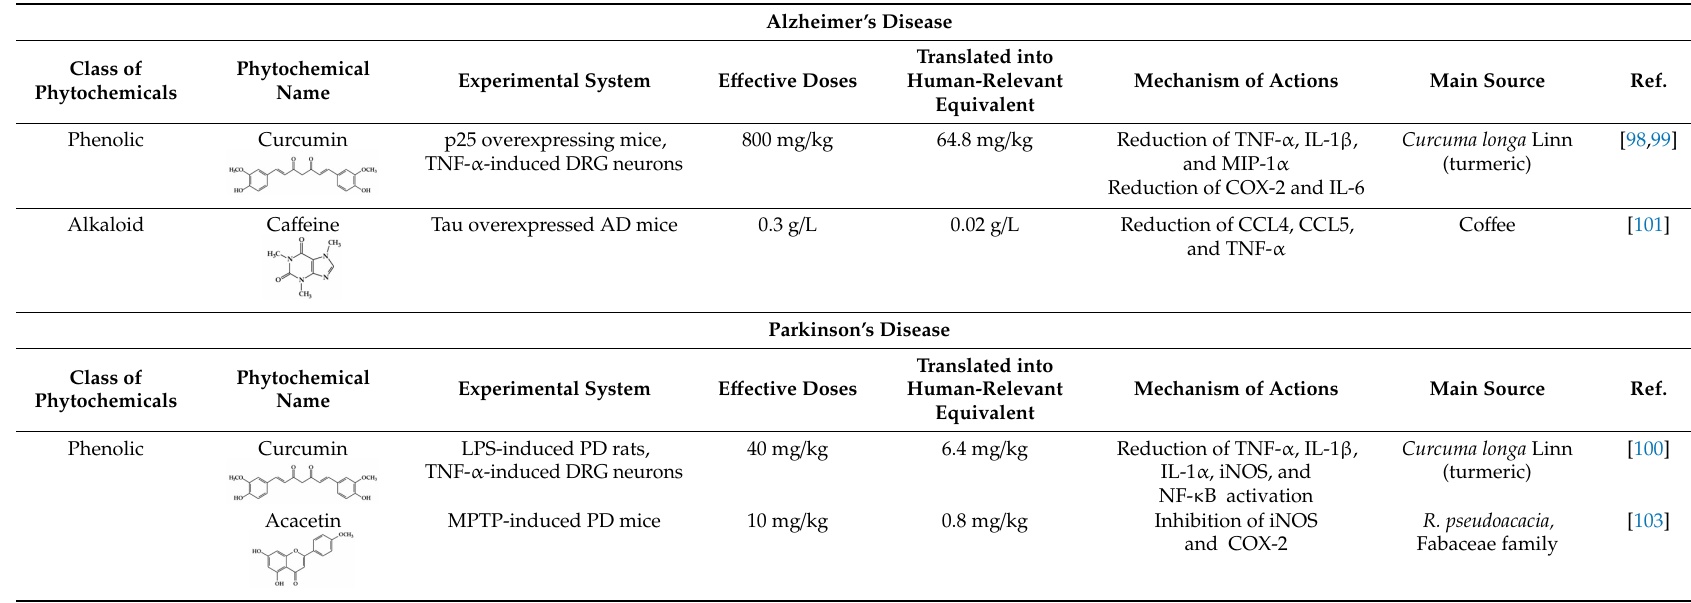
Table 3. Phytochemicals and their e ff ective mechanism in neurodegenerative